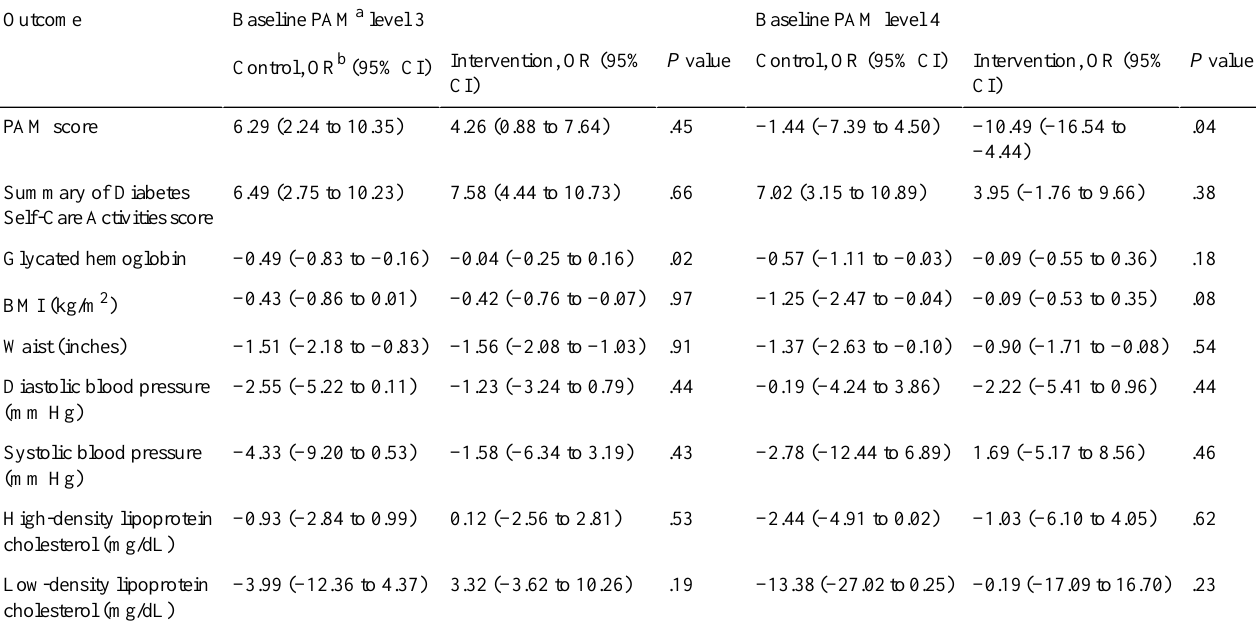
Table 6. Analysis of change from baseline to study end baseline Patient Activation Measure level